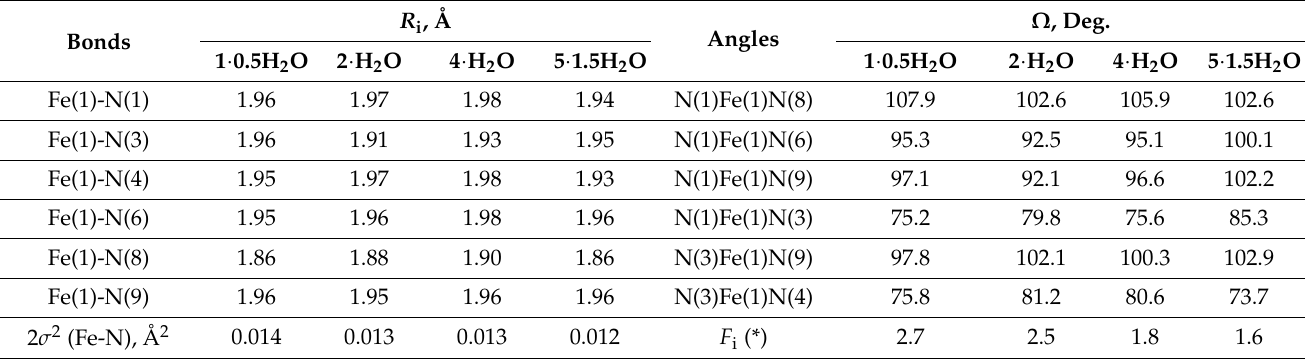
Table 1. Microstructure parameters of the Fe coordination site for the complexes at T = 300 K (LS) obtained by EXAFS fitting with multiple scattering approximation ( R i —interatomic distance, 2 σ i2 — Debye–Waller factor, F i —the statistical error of the fitting).